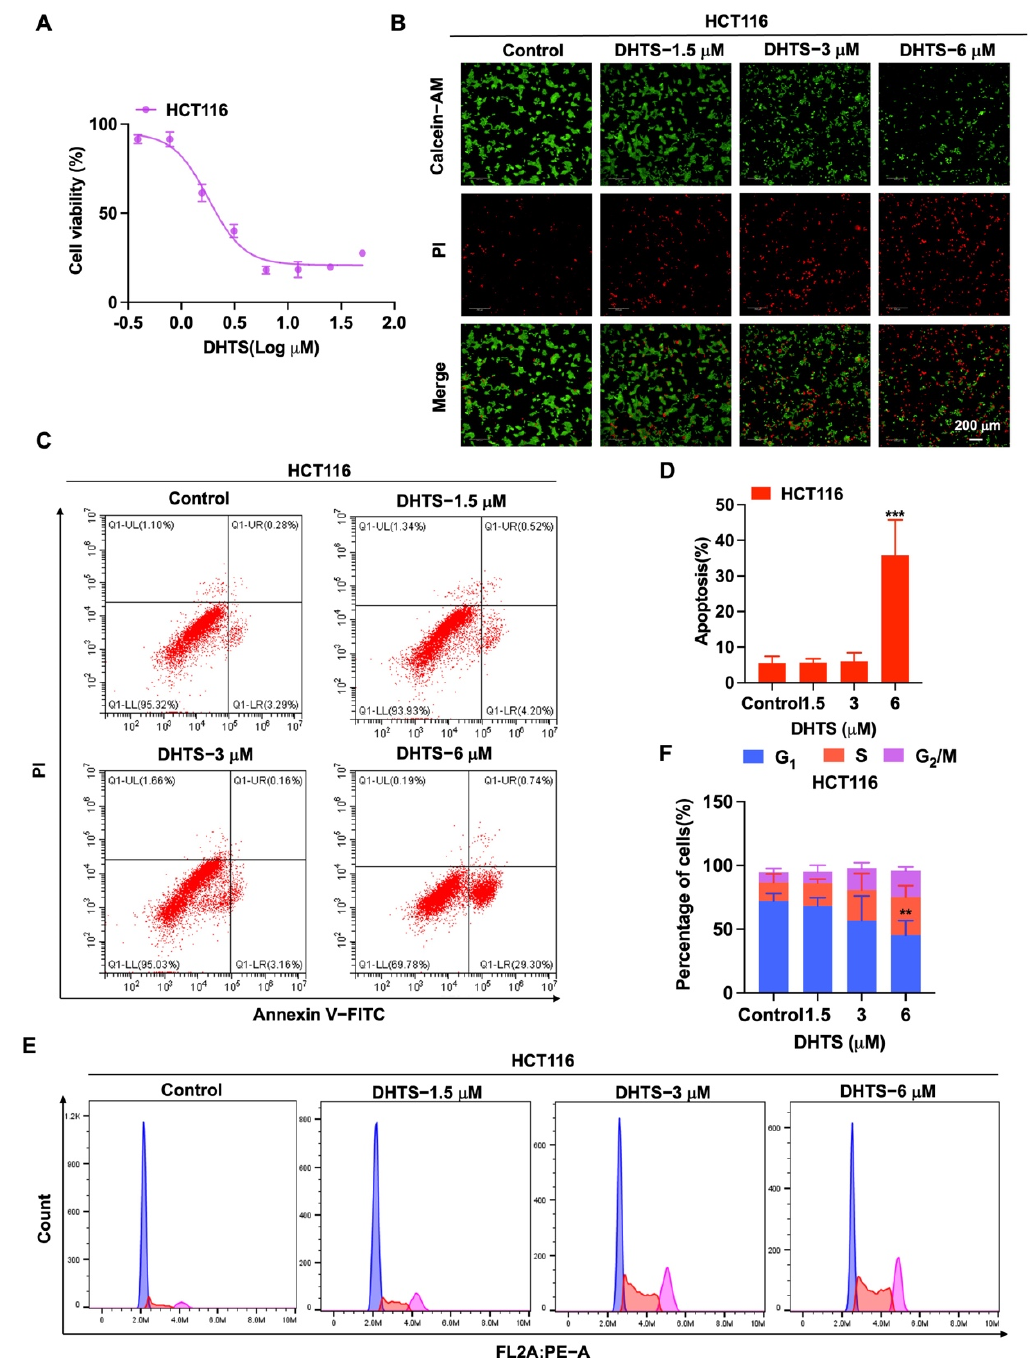
Figure 2. DHTS inhibited proliferation and apoptosis of HCT116 cells. ( A ) Cells proliferation assay of HCT116 cells after DHTS treatment at different concentrations for 24 h by CCK-8 assay; ( B ) cells proliferation assay of HCT116 cells after DHTS treatment at 1.5, 3, and 6 μ M for 24 h by Calcein- AM/PI staining; ( C – F ) HCT116 cells were treated with DHTS at 1.5, 3 and 6 μ M for 24 h. Apoptosis and cell cycle distribution of HCT116 cells were detected by flow cytometry (compared to the con- trol group, ** p < 0.01, *** p < 0.001). group, ** p < 0.01, *** p <